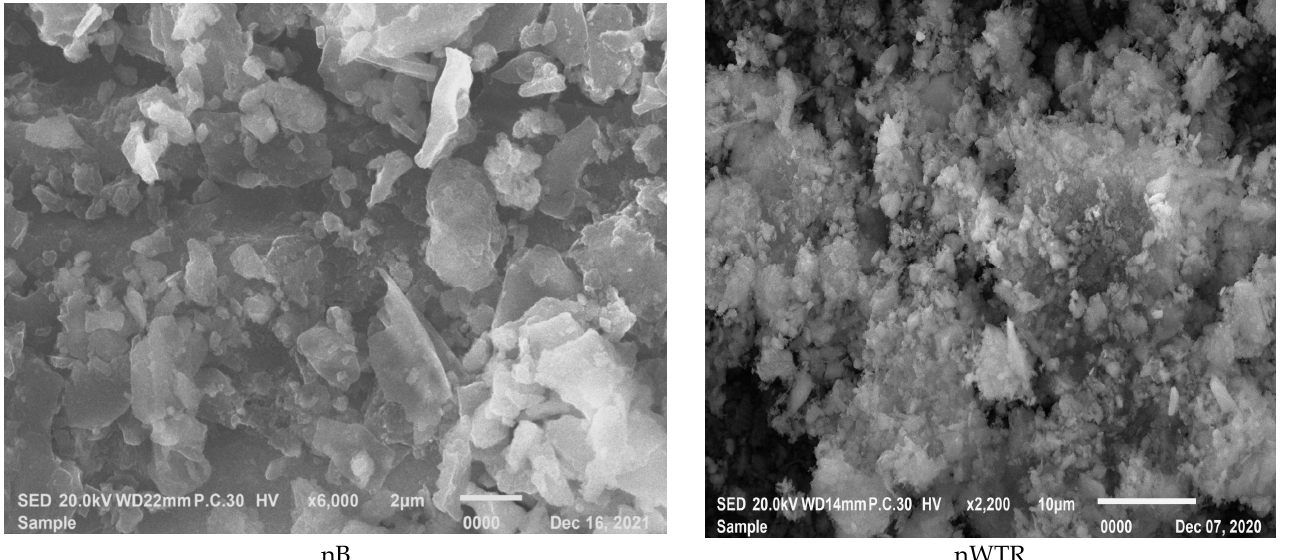
Figure 3. Scanning electron microscopy (SEM) images for nanobiochar (nB) and nanowater treatment residuals (nWTR).